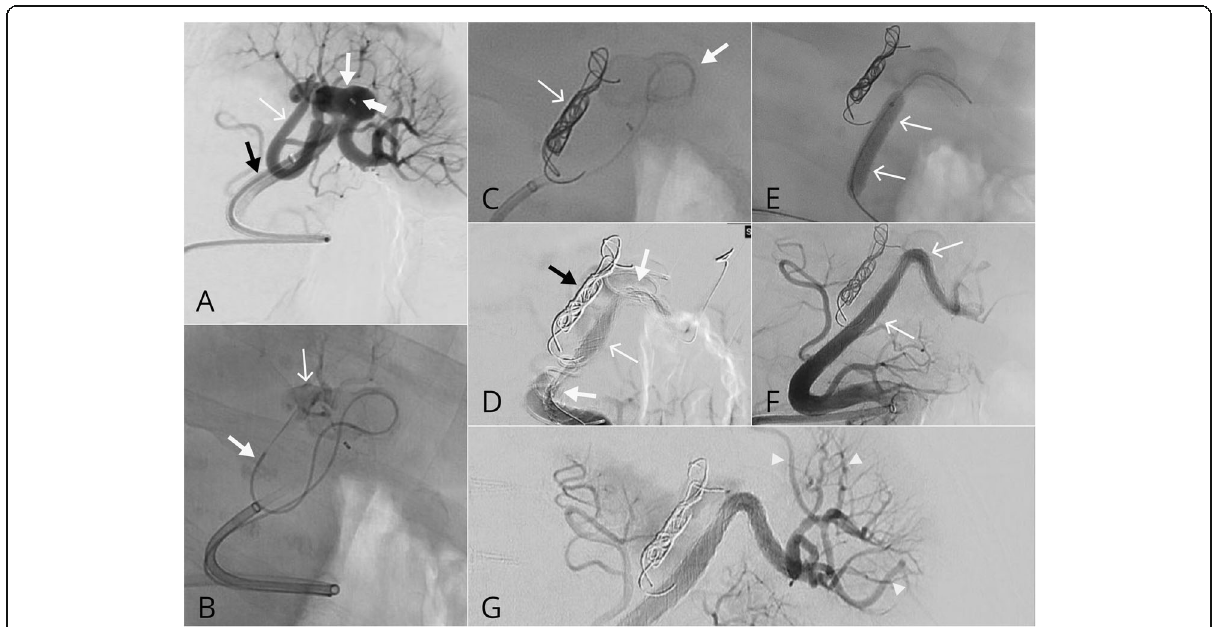
Fig. 3 Complex distal splenic artery anerysm. a Initial angiography demonstrated a wide necked bilobed splenic artery aneurysm (thin white arrow) arising at a bifurcation and incorporating 2 outflow arteries. Note the presence of a 6Fr NeuronMAX 088 guide sheath (black arrow) and 5Fr Sofia (thick short white arrow) within the lateral lobe of the aneurysm. The medial outflow artery (thinnest white arrow) was targeted for sacrifice. b using a microcatheter (thick white arrow) the medial branch was coil sacrificed using detachable Target 360 XL coils. Note the aneurysm (thin white arrow). c following coil deployment (thin white arrows). d Overlapping CASPER stents (white arrows) were subsequently deployed across the aneurysm neck. Note two points of stent narrowing proximally and distally (thick white arrows) with ongoing occlusion of the medial branch (black arrow). e Angioplasty using an 8 × 40 mm Armada balloon (white arrows) resulted in f marked improvement of luminal diameter and angiographic appearances. g Distal splenic branches remained patent